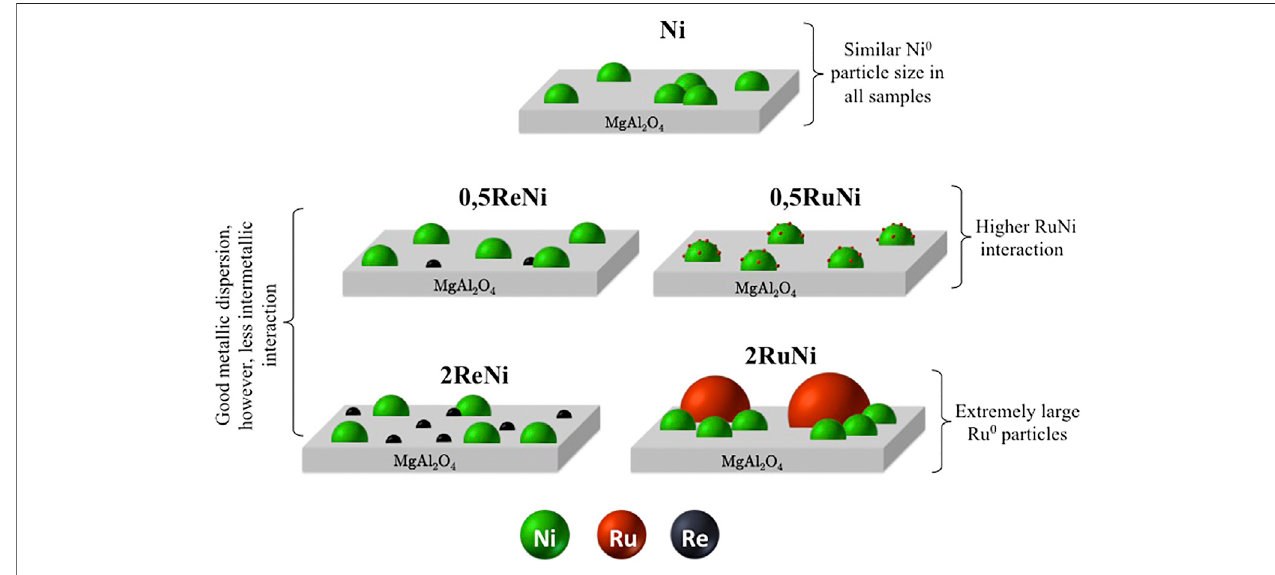
FIGURE 5 | Graphical representation of the synthesized samples.